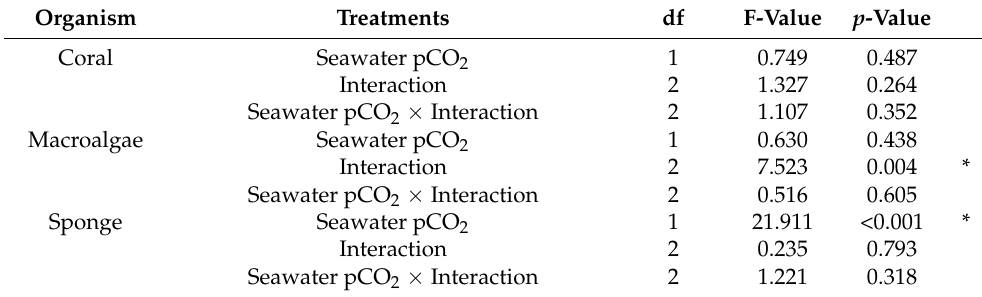
Figure 1. Growth responses (mean ± 1 se) of ( a ) corals, ( b ) macroalgae, and ( c ) sponges exposed to ambient pCO 2 (blue) and elevated pCO 2 (orange) treatments over 28 days. Data were statistically analyzed with a two-way analysis of variance (ANOVA). The small letters (a, b) represent statistical differences between pCO 2 treatments, and the capitalized letters (A, B) represent statistical differences between interaction treatments. The full results of the two-way ANOVA are presented in Table 2. Table 2. Statistical analyses of coral, macroalga, and sponge growth in response to seawater pCO 2 and interaction treatment. * indicates statistical significance.